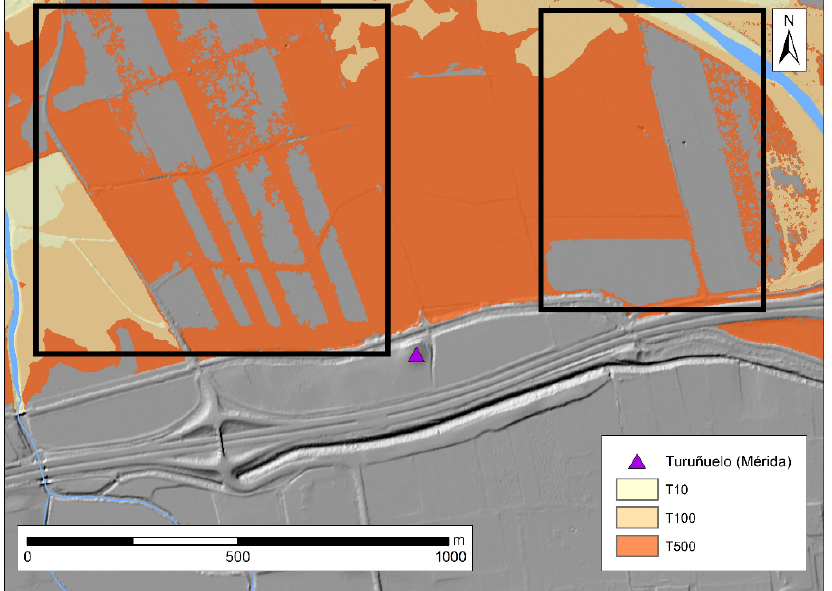
Figure 6. APSFR analysis corresponding to the territory where the Turuñuelo tumulus is located (Mérida, Badajoz, Spain). When observing the area affected by the T500 flood event, some information gaps can be detected (marked with a black rectangle), with a rectangular pattern, which are identified with the plots planted with maize. The density of this crop means that during the data interpolation exercise for the elimination of vegetation, the programme interprets it as a solid surface.